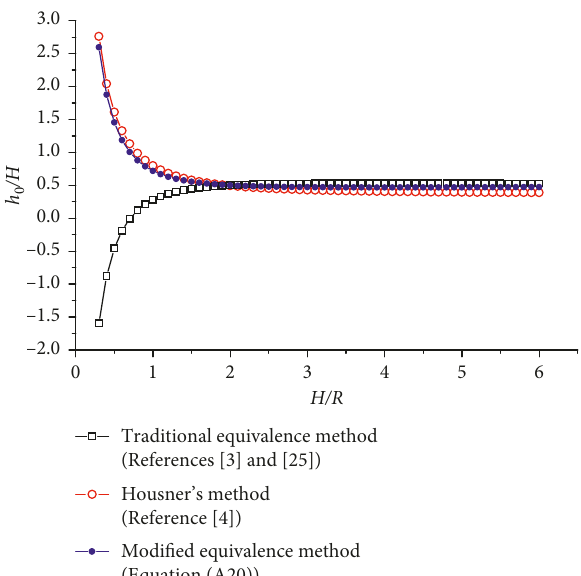
Figure 12: Position ratio h (cylindrical